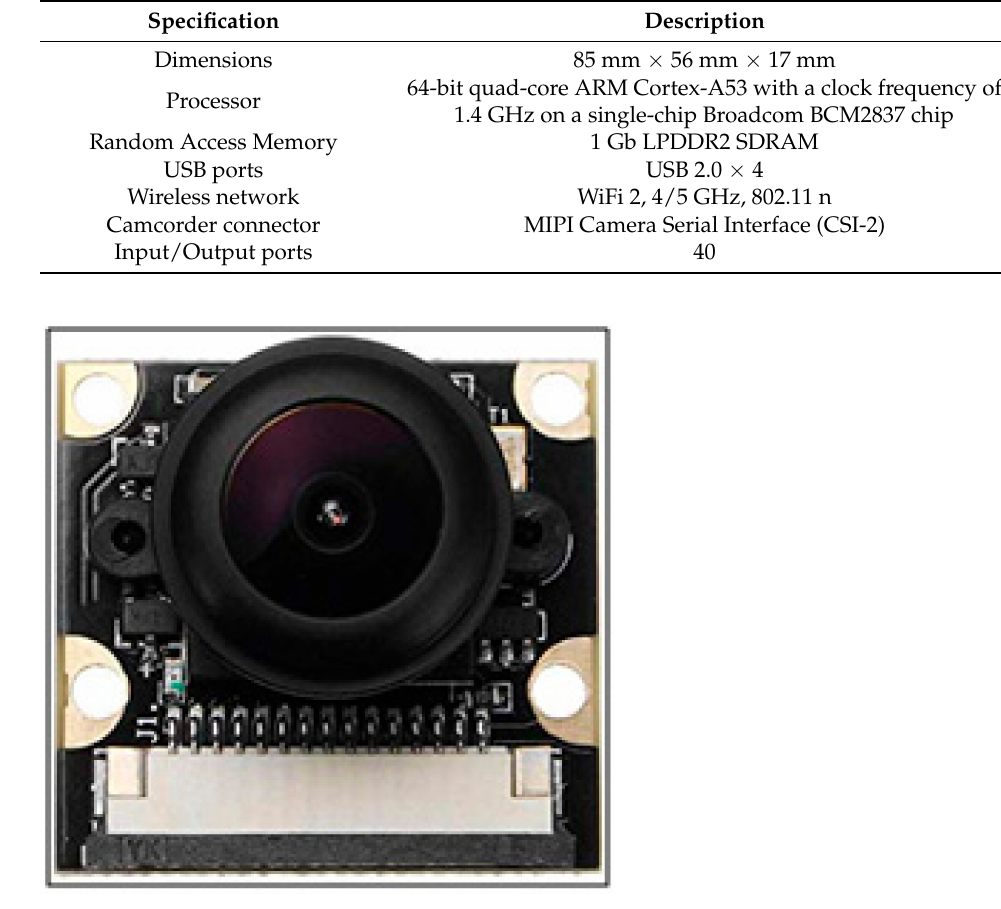
Figure 2. Camera. Table 2. Specifications of